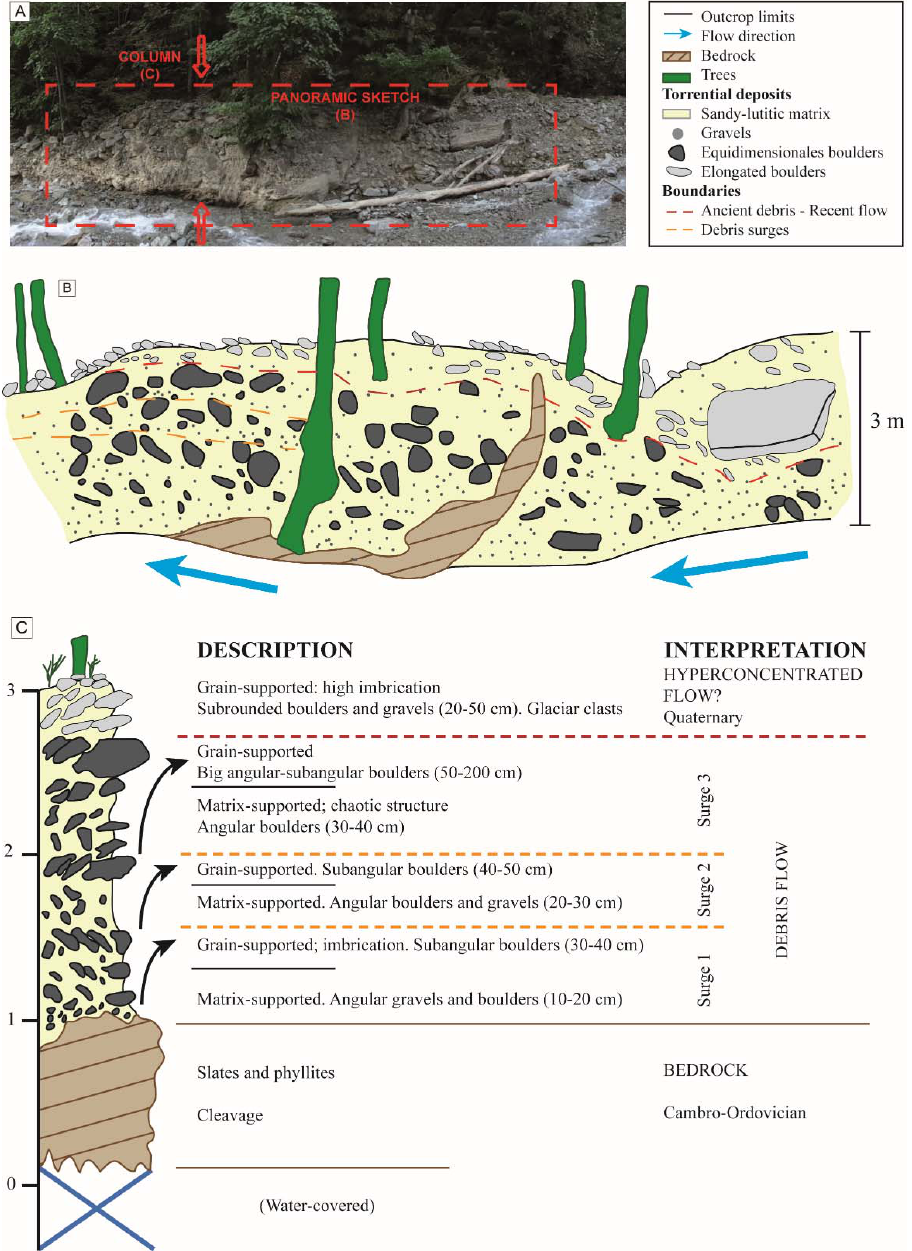
Figure 4. Study of the torrential deposits in the right margin of the lower reach of the Caners stream. ( A ) Photo of the outcrop and location of the sketch and the column. ( B ) Panoramic sketch with the interpretation of materials and torrential episodes. ( C ) Stratigraphic column with the description of the sedimentary packages identified, and the interpretation of the torrential process that generated each of them.